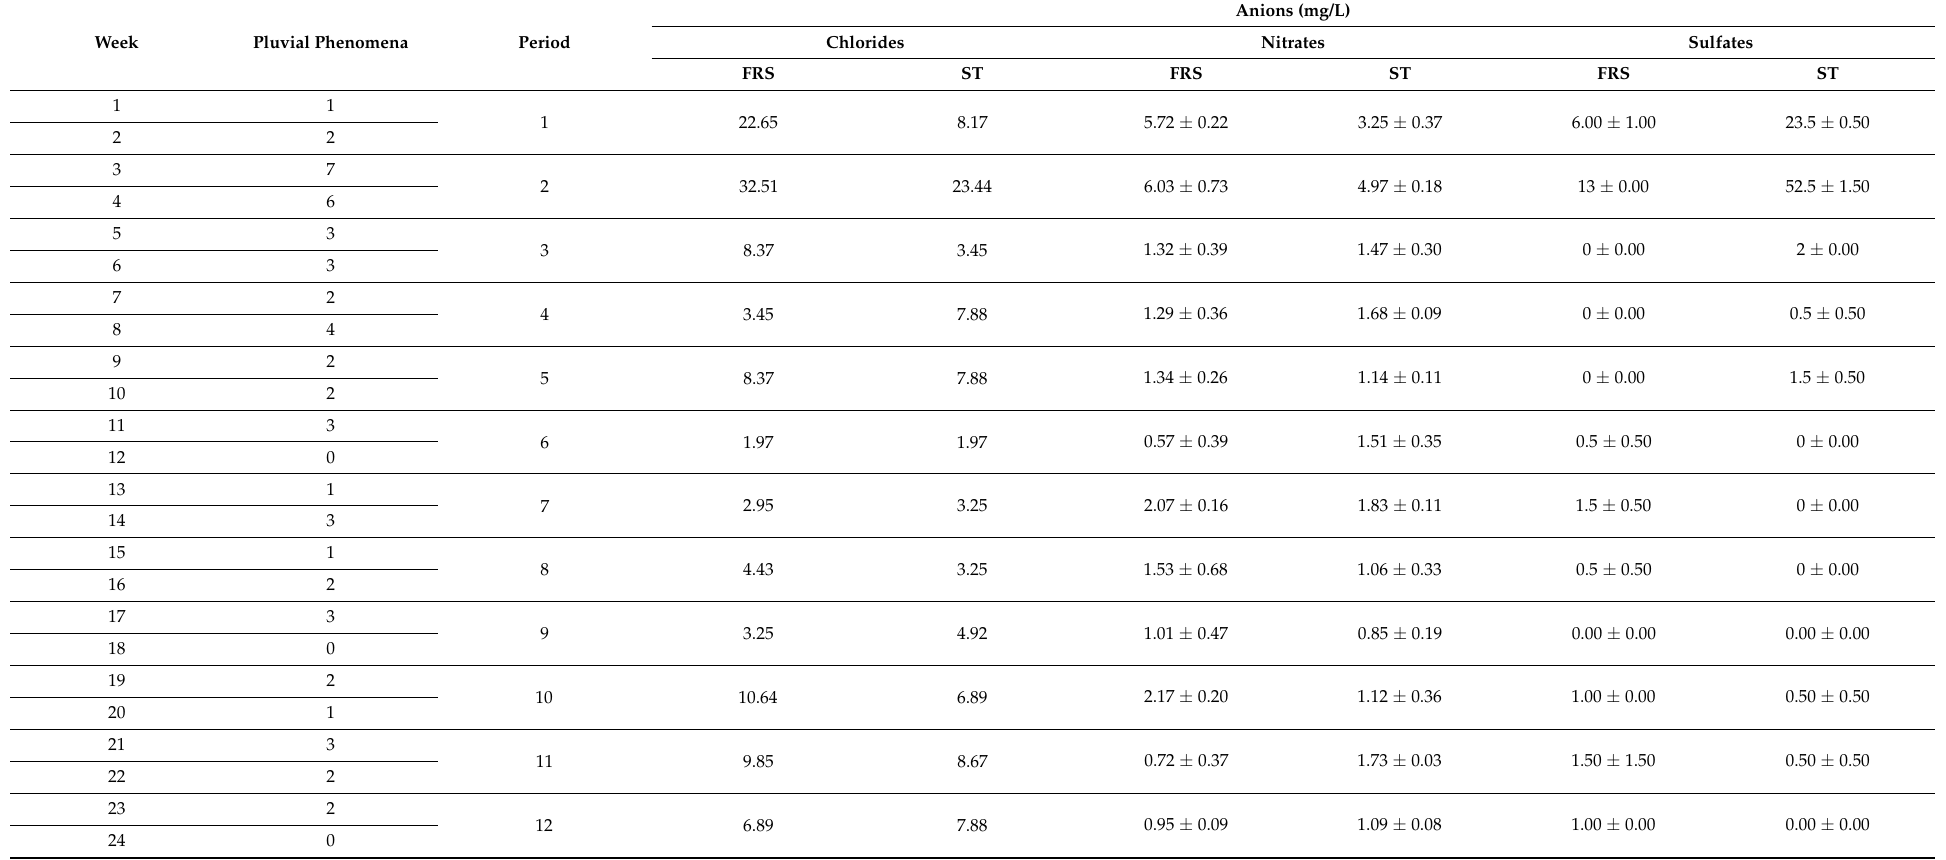
Table 3. Concentration of major anions in rainwater samples from the basic geostatistical area 2736, year 2021. Anions (mg/L) Chlorides Nitrates Sulfates Week Pluvial Phenomena Period FRS ST FRS